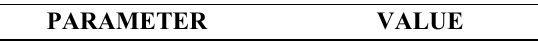
Figure 8. Hyperplanes technique